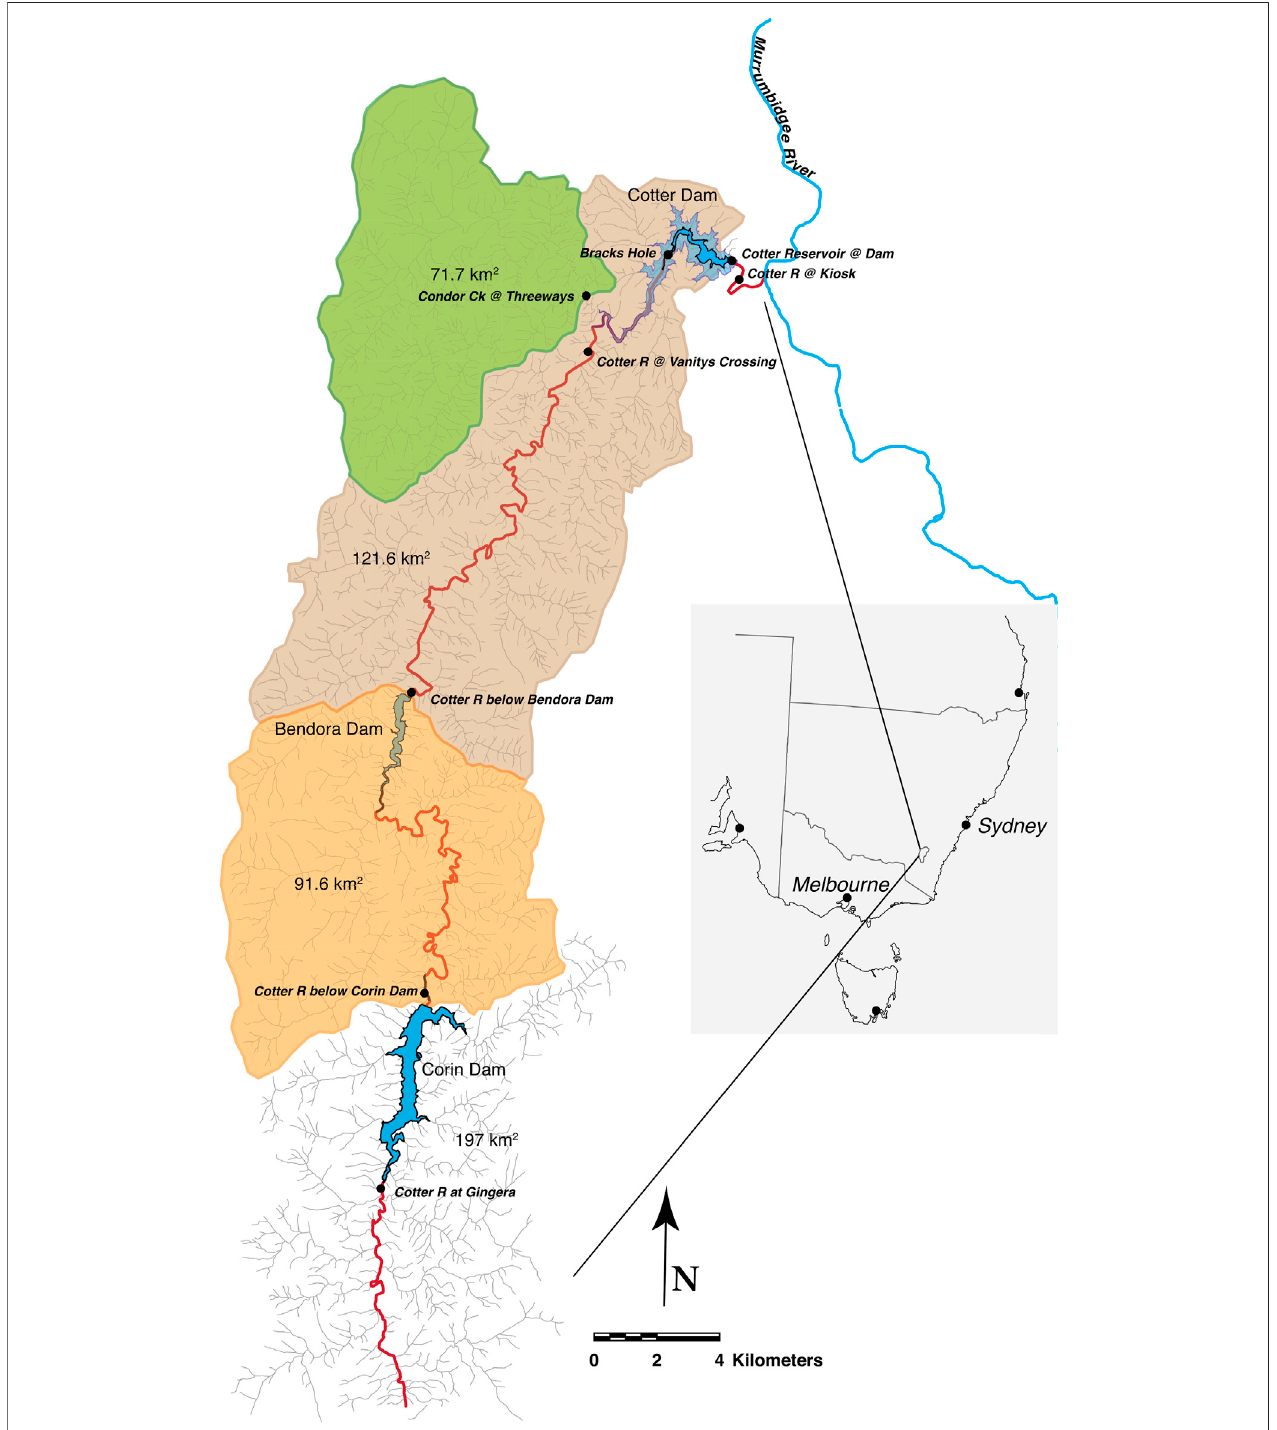
FIGURE 1 | Cotter Reservoir catchment showing hydrologic gauging stations and upstream reservoirs. Shaded areas denote catchment areas: orange between Corin and Bendora Dams; brown between Bendora and Cotter Dams not including Condor Ck; green Condor Ck subcatchment. Original full surface level of Cotter Reservoir is shown in dark blue and for enlarged Cotter Dam in light